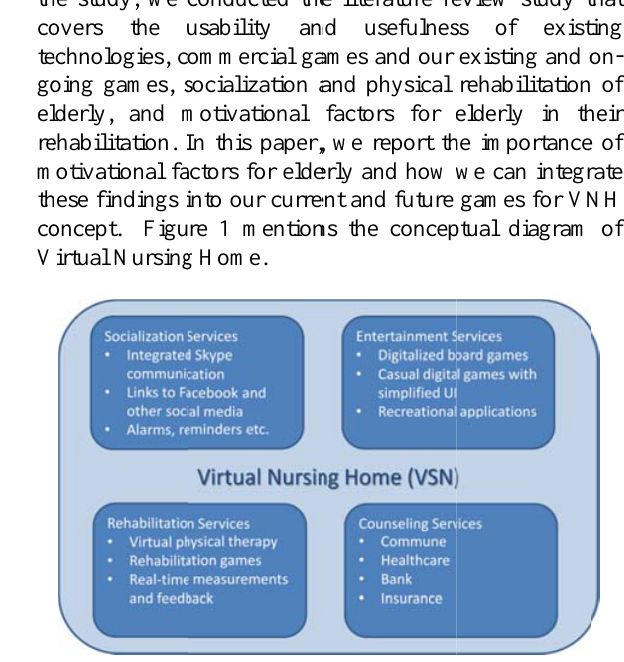
Table 1. Ind ication to the e game